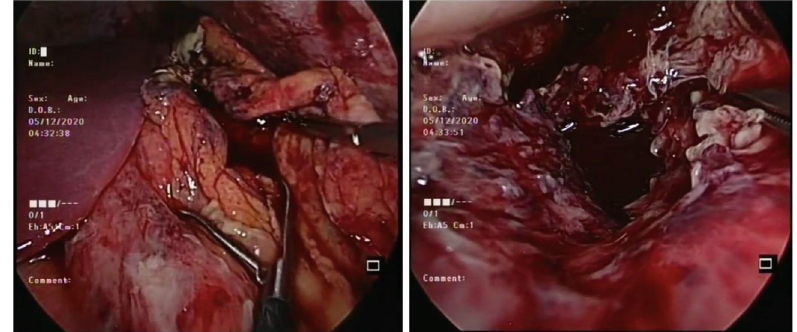
Figure 2: Widened opening at the gastro-colic omentum and the opening of the cavity of the necrotic collection following drainage.